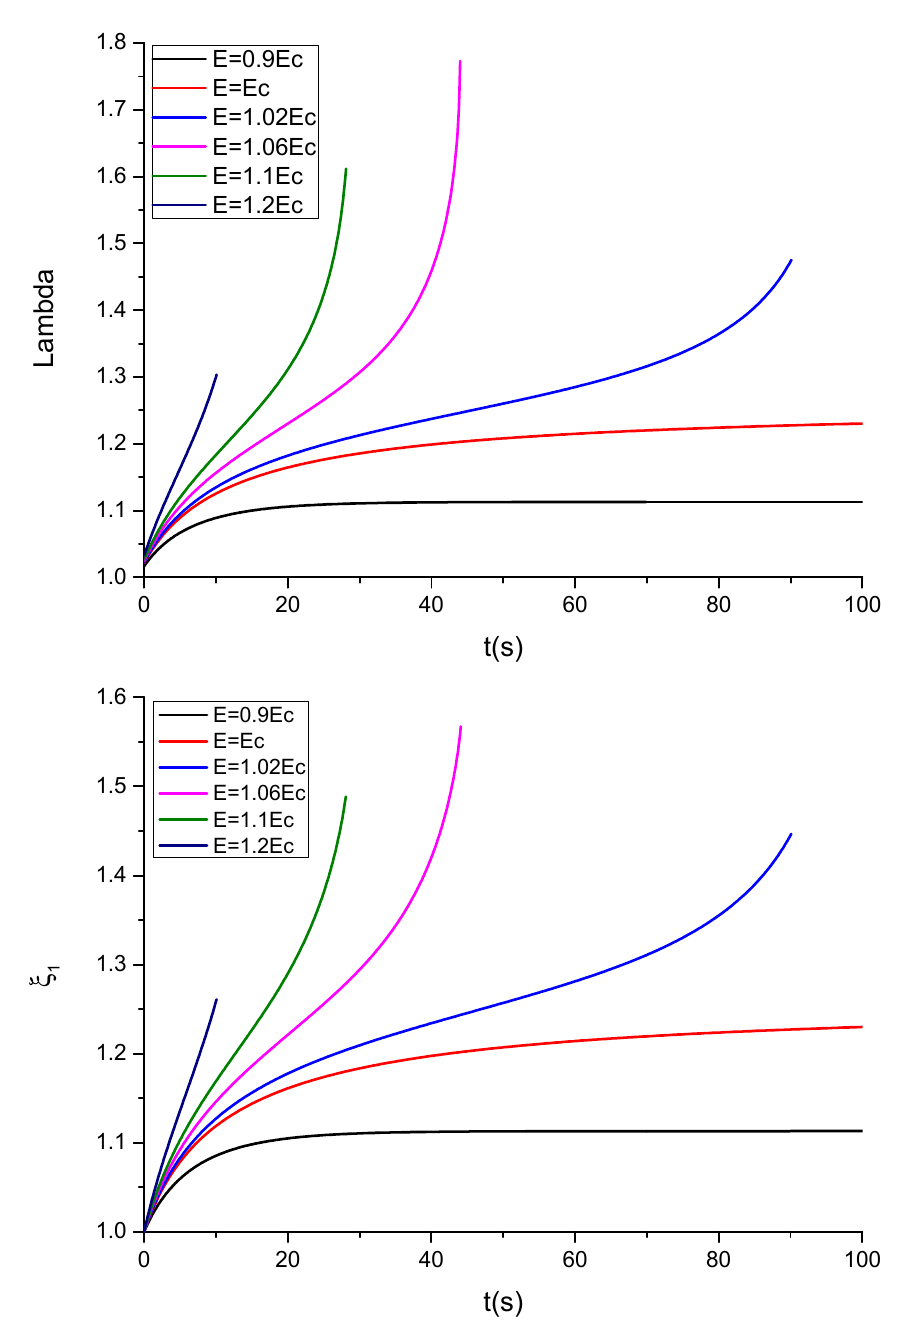
Figure 8. Plots showing the evolution of λ and ξ, as a function of time for different values of the electric field E, for the case of a neo-Hookean material with compliant electrodes without mechanical stresses.